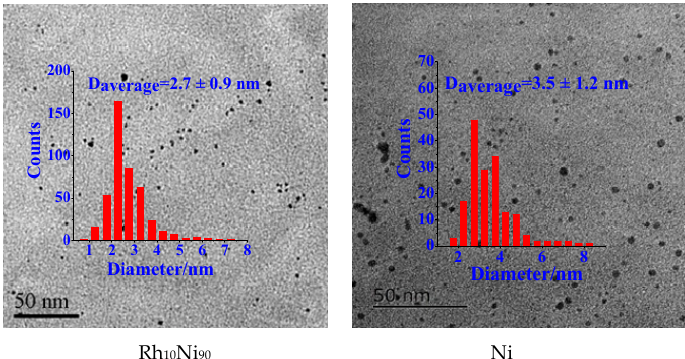
Figure 2. Transmission electron microscopy (TEM) images and size distribution histograms of colloidal dispersions of Rh (100–x) Ni x (x = 0, 10, 30, 70, 90 and 100) NPs ( R ISO = 40, C Metal = 0.66 mM, reduced under ice-water bath for 1 h).